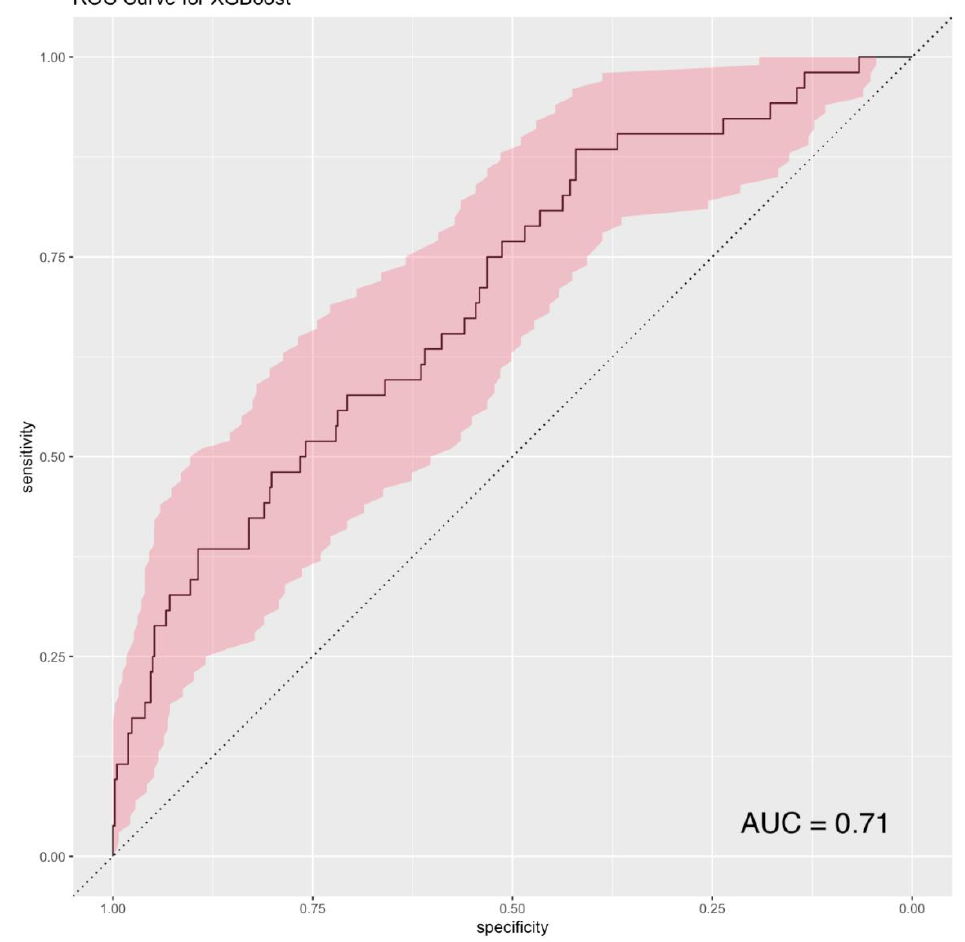
Figure 2. Receiver operator characteristics (ROC) curve for the XGBoost model. AUC: area under receiver operator characteristics curve.